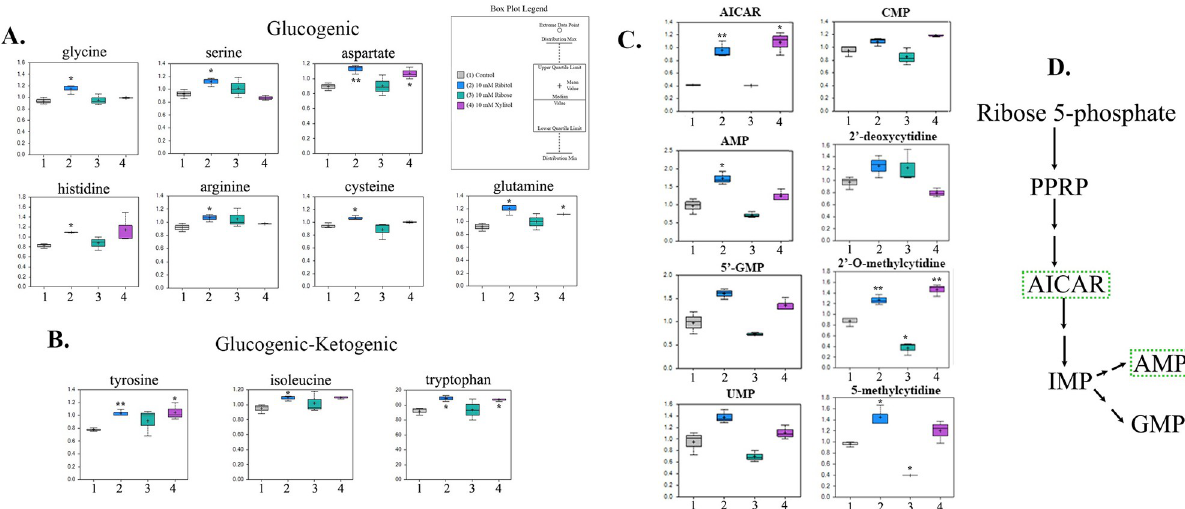
Fig 4. Alteration of glucogenic and glucogenic-ketogenic metabolites and nucleotide metabolism in MCF-7 breast cancer cells, treated with ribitol, ribose, and xylitol. (A) All glucogenic amino acids levels were increased after ribitol treatment compared to ribose and xylitol. (B) Glucogenic and ketogenic amino acids such as tyrosine, phenylalanine and tryptophan levels were increased in ribitol treated cells compared to ribose and xylitol treatment. (C) Ribitol treatment increases the nucleotide synthesis by increasing the purines and pyrimidines synthesis, compared to ribose and xylitol treatment and Ribitol treatment significantly increased the level of 5-aminoimidazole-4-carboxamide ribonucleotide (AICAR), one of the key intermediates of nucleotide synthesis. Significance denoted by � p � 0 . 05 , �� p � 0 . 01 , ��� p � 0 . 001 within individual metabolite box plots, as determined by Welch’s two-sample